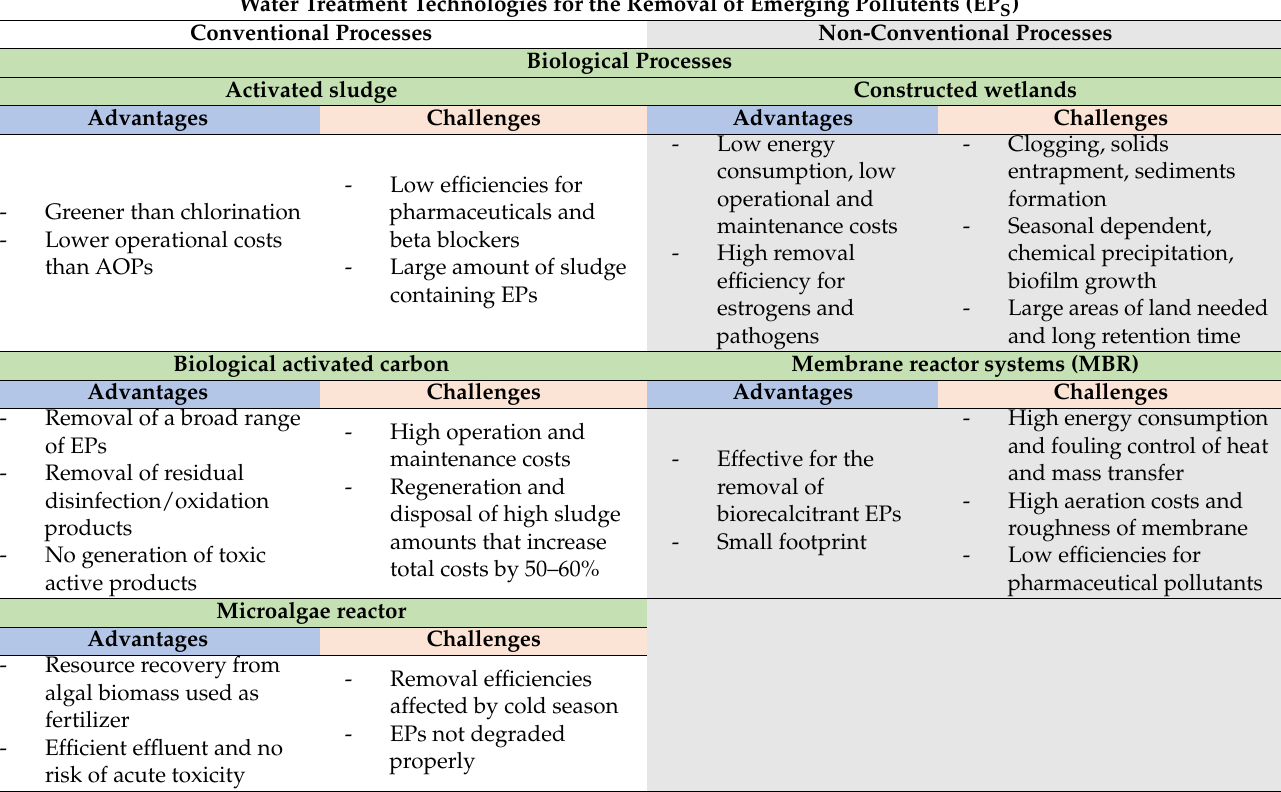
Table 1. Advantages and future challenges for applying conventional and non-conventional processes for EP